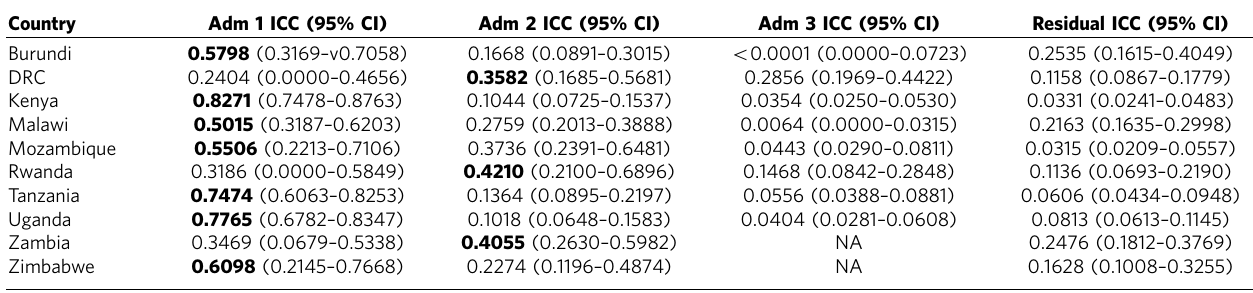
Table 3 | Sub-national variation in vaccination coverage. Country